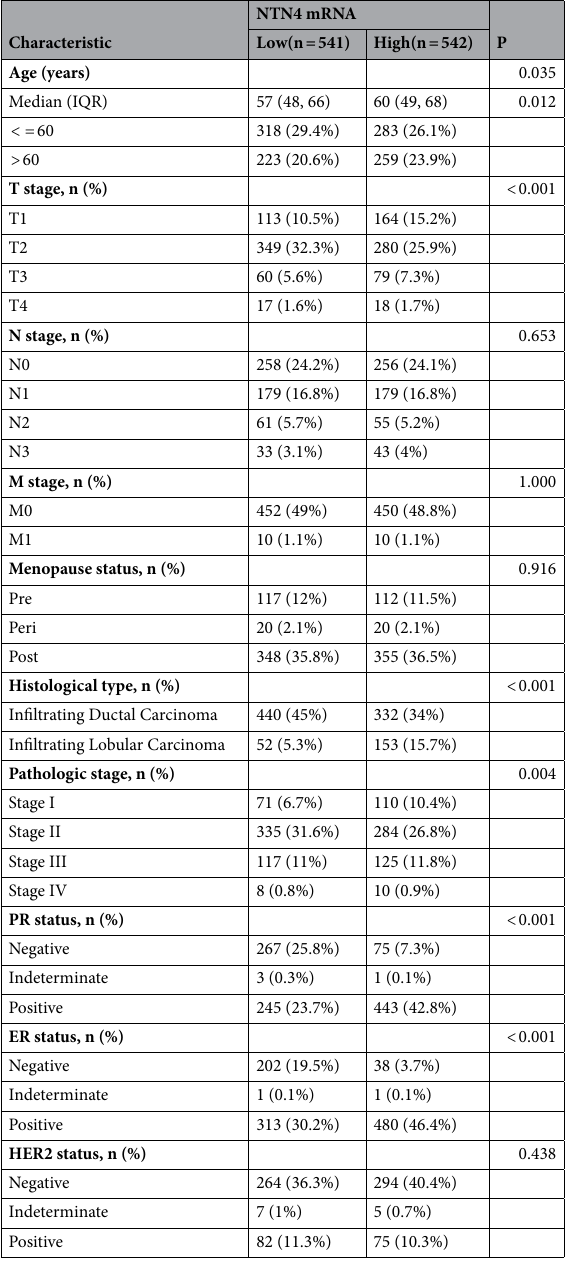
Table 1. The relationship between the expression of NTN4 and clinicopathological data. IQR interquartile